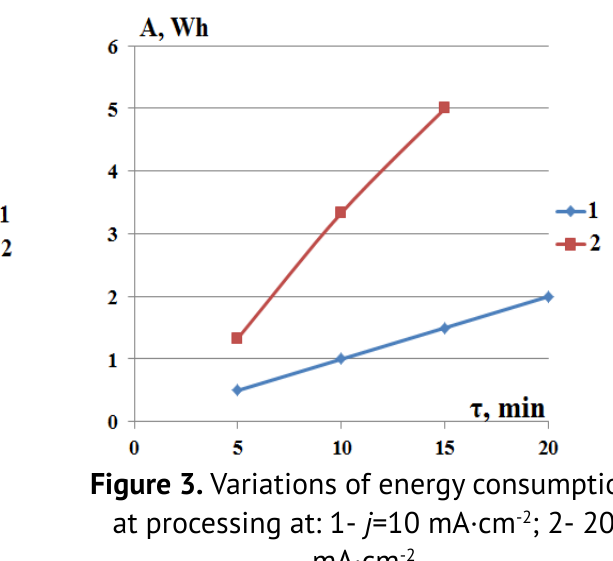
Figure 3. Variations of energy consumption at processing at: 1- j =10 mA·cm -2 ; 2- 20 mA·cm